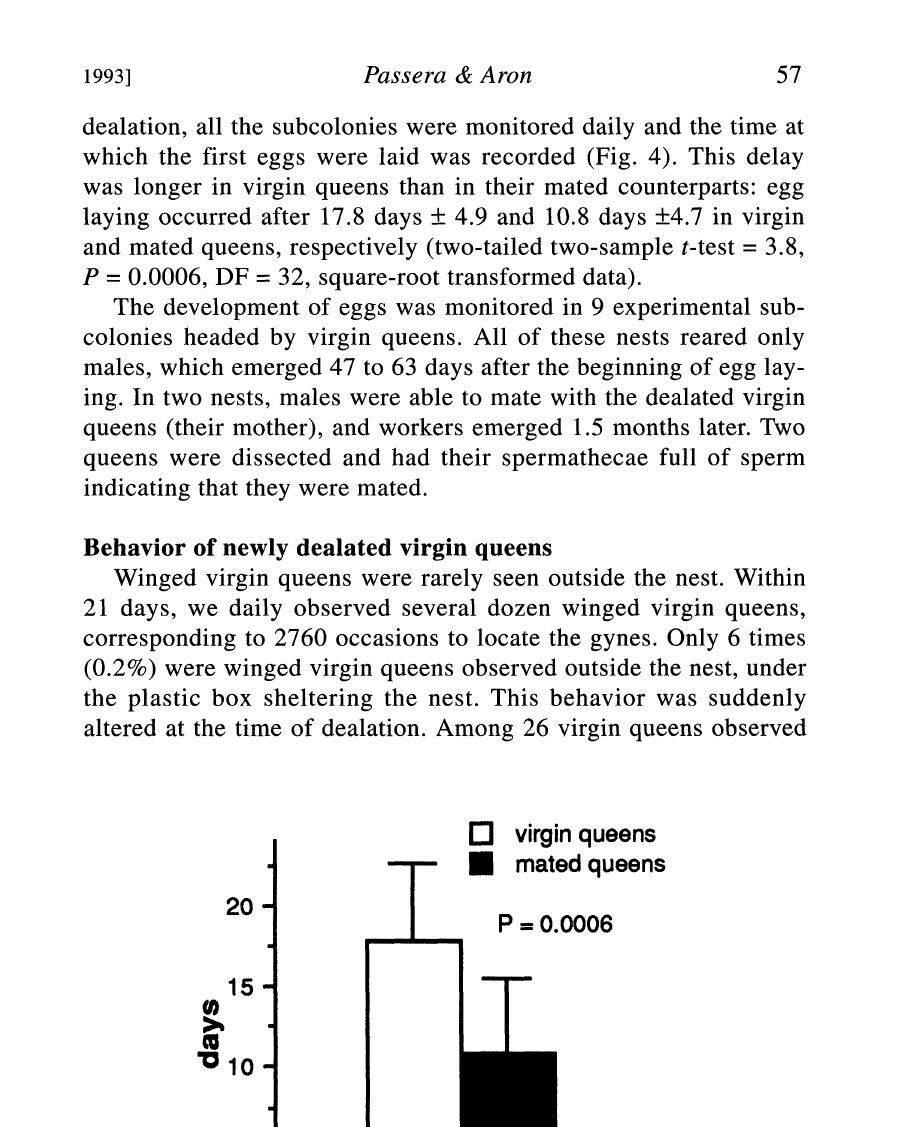
Fig. 4. Time delay between dealation and egg laying in 8 subcolonies containing virgin queens and 26 units containing newly mated queens. Shown are means +